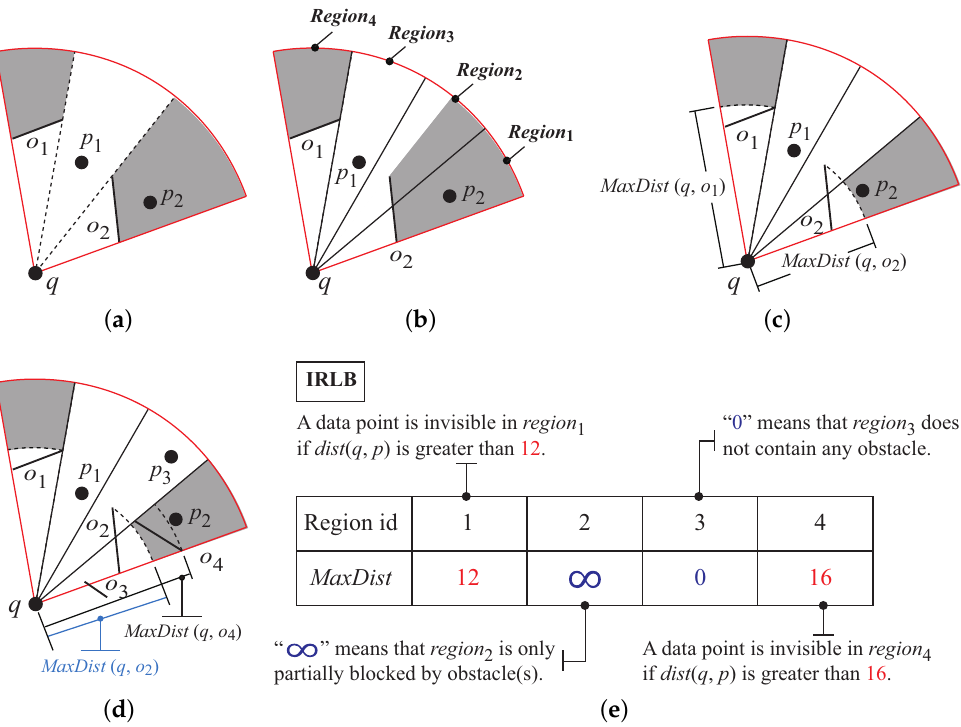
Figure 21. ( a ) Irregular invisible regions. ( b ) Equally split the view field into several small regions. ( c ) Use MaxDist ( q , o ) to represent an invisible region. ( d ) Region 1 contains multiple obstacles. ( e ) The IRLB of ( c , d